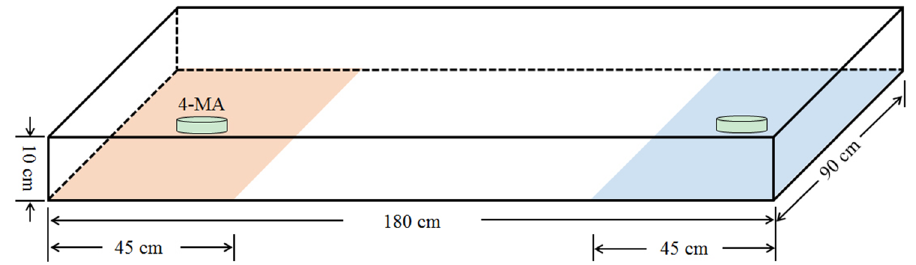
Figure 7. Setup for behavioural preference of Protaetia brevitarsis in a dual-choice arena system. The yellow and blue part represented treated and control compartment, respectively. The beetles were initially positioned in the center of the arena. Two short cylinders represent the 9-cm petri dish which is filled with 1.5%